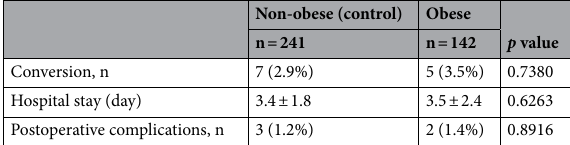
Table 6. Operative outcomes.